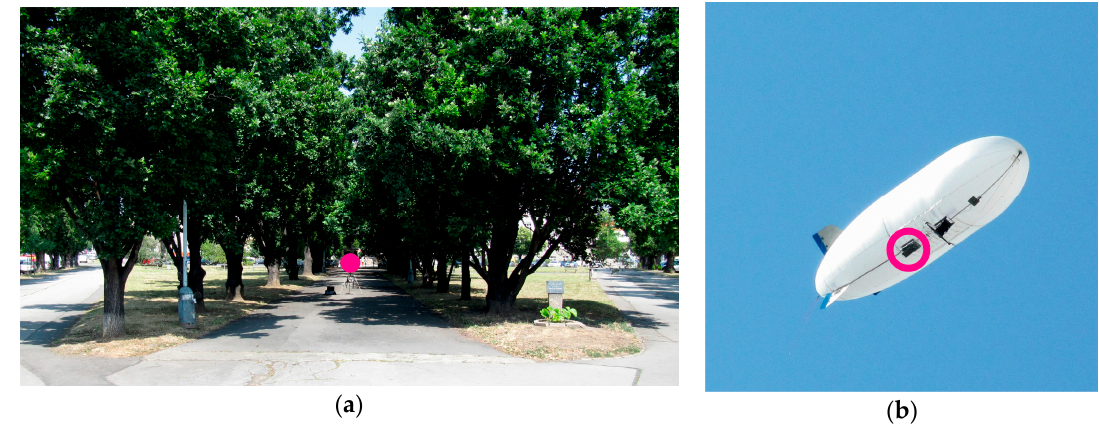
Figure 8. The selected measurement scenario at Fleming Square in Prague, the Czech Republic: ( a ) location of the receiver marked by the magenta dot; ( b ) UAV during a flight, the Tx antennas placed on the 3D positioner are marked by the magenta circle.